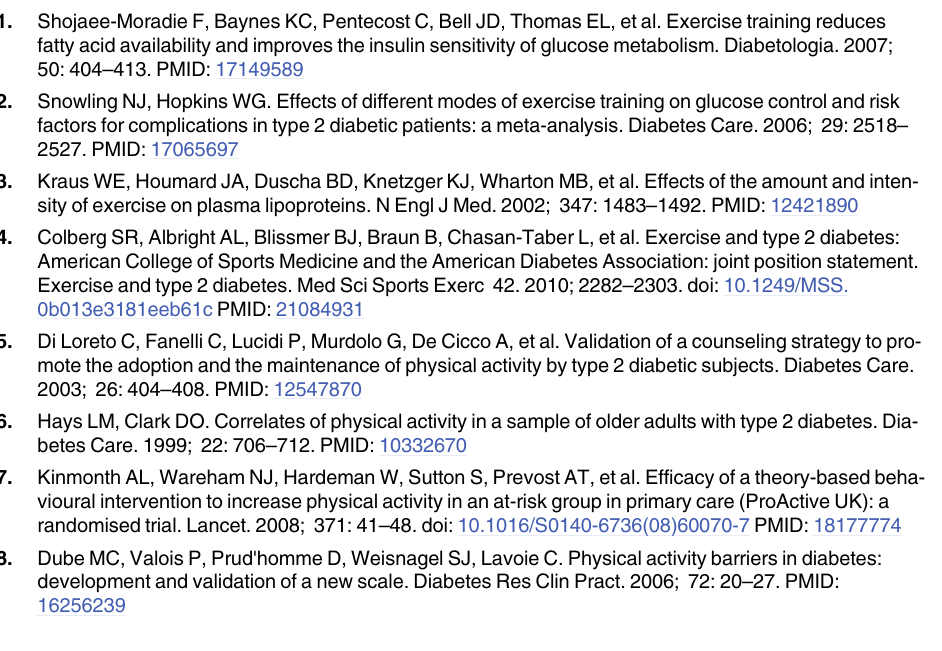
S1 Fig. Flowchart of study participants (GPs and patients). S2 Fig. Multivariate mixed modeling of patient ’ s BAPAD with patient ’ s and general practi- tioner ’ s characteristics (regression coefficients and 95%